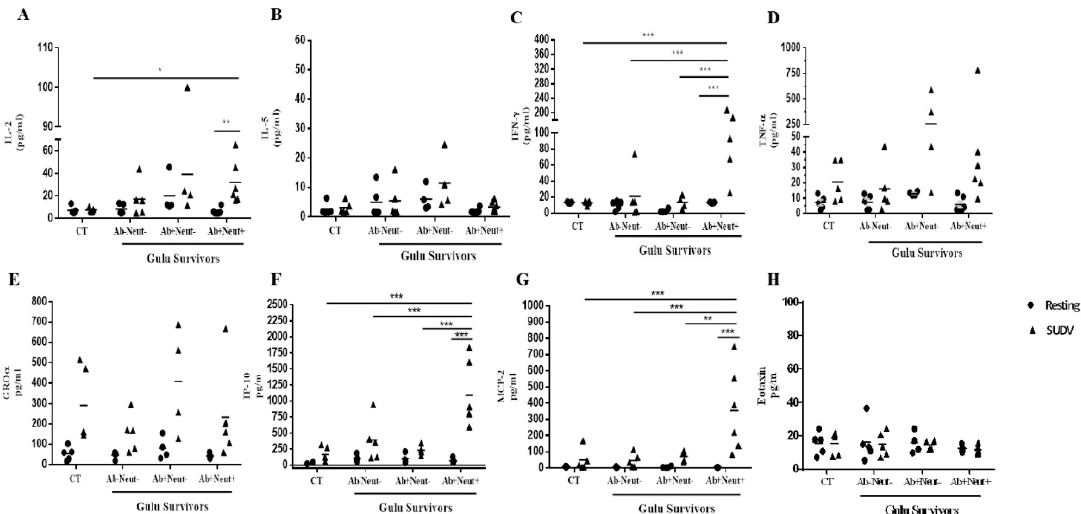
Figure 4. Multiplex DLISA of cytokines and chemokines secretion analysis of whole blood from survivors and non-infected controls following SUDV whole antigen stimulation. Cytokine and chemokine levels of IL-2 ( A ), IL-5 ( B ), IFN γ ( C ), TNF α ( D ), GRO α ( E ), IP-10 ( F ), MCP-2 ( G ), and Eotaxin ( H ) were measured in the plasma supernatants of whole blood samples by multiplex ELISA following SUDV antigen whole blood stimulation and in the resting state (non-stimulated). Survivors are grouped according to the presence of IgG antibodies to SUDV antigen or GP 1-649 and ability to neutralize live SUDV (Table 1). CT: non-infected controls, Ab: antibody, Neut: neutralizing; IL: interleukin, IFN: interferon, TNF: tumor necrosis factors, IP: IFN γ -inducible protein, MCP: monocyte